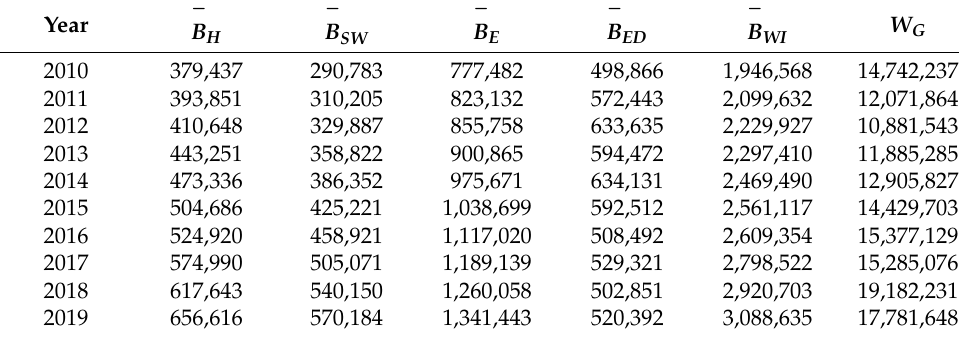
Table 3. Macro-economic wealth inequality model W G